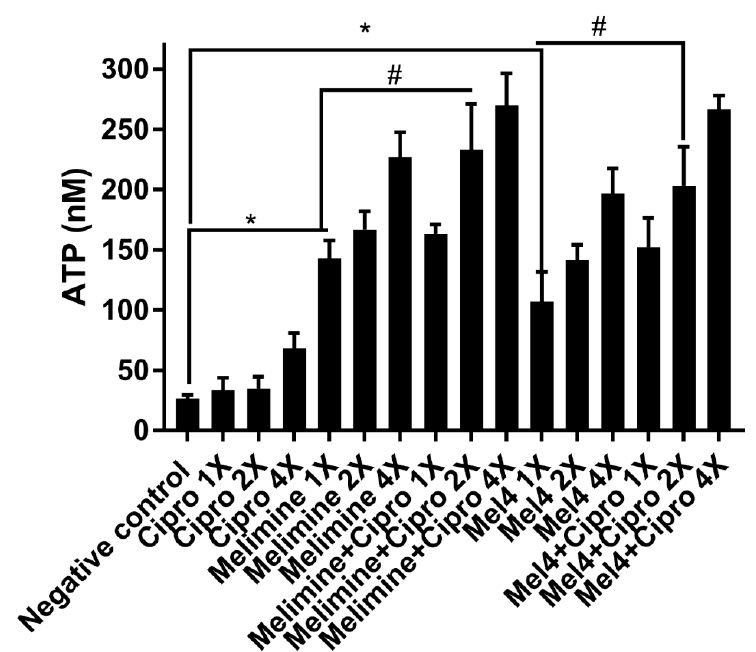
Figure 7. Leakage of ATP from pre-formed biofilm cells of S. aureus ATCC 25923. Leakage of ATP following treatment for 3 h with either of the two peptides and ciprofloxacin alone or in combination. The strain was made resistant to ciprofloxacin by passage for 30 days at a sub-MIC. * represents significant ( p < 0.001) increases in the amount of extracellular at inhibitory concentrations of peptides ATP compared to the negative control. # represents significant ( p < 0.001) increase in the release of ATP of the combination of melimine or Mel4 with ciprofloxacin compared to melimine or Mel4 alone.